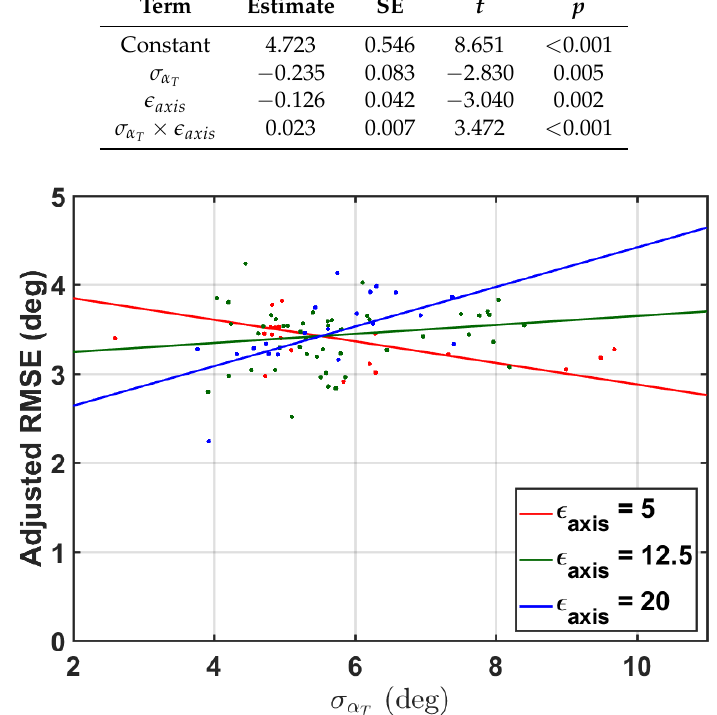
Figure 6. The linear model, plotted as a function of σ α and (cid:101) axis . The points selected have been T adjusted by the estimated subject intercept (random effect) so that multiple subjects can be presented with the same linear regression lines (plotted using only the fixed effects and Constant). The points selected for each line were those that had (cid:101) axis ± 2.5 ◦ about the selected